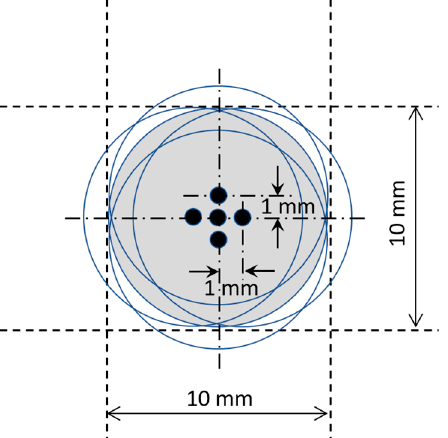
Figure 9. Multiple artificial-finger touch positions at each sensing position on sensing area.